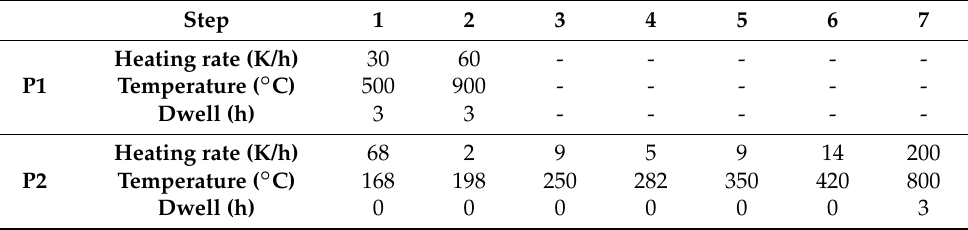
Table 3. Debinding strategy for the different